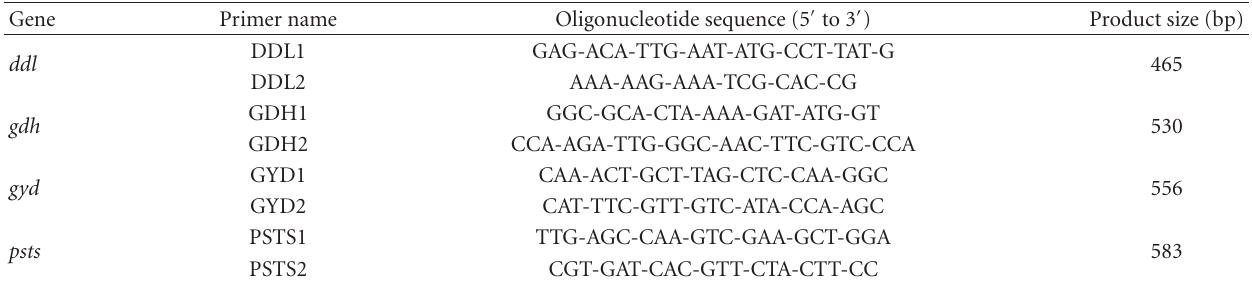
Table 4: Amplification and sequencing primers for ddl, gyd, gdh, and